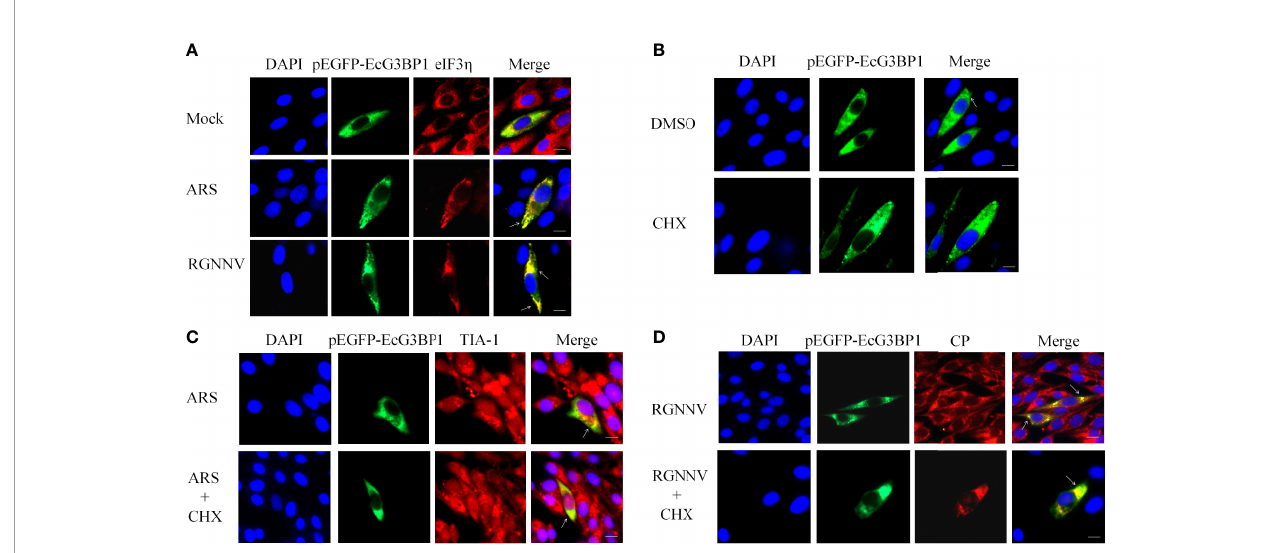
FIGURE 2 | RGNNV infection induced the formation of classic types of SGs. (A) GS cells were transfected with pEGFP-EcG3BP1 then treated or not treated with ARS (positive control) for 1 h or RGNNV for 24 h. eIF3 h was used to indicate the formation of classical SGs. (B) pEGFP-EcG3BP1 was transfected into GS cells. After 24 h, the cells were treated with DMSO or CHX for 1 h. (C) GS cells were transfected with pEGFP-EcG3BP1 plasmids. After 24 h, the cells were treated with ARS for 1 h and then CHX for 1.5 h. TIA-1 was used to indicate the formation of SGs. (D) pEGFP-EcG3BP1 was transfected into GS cells, which then were incubated with RGNNV at 24 h post-transfection. The cells were treated with CHX for 1.5 h and then analyzed after staining with anti-CP